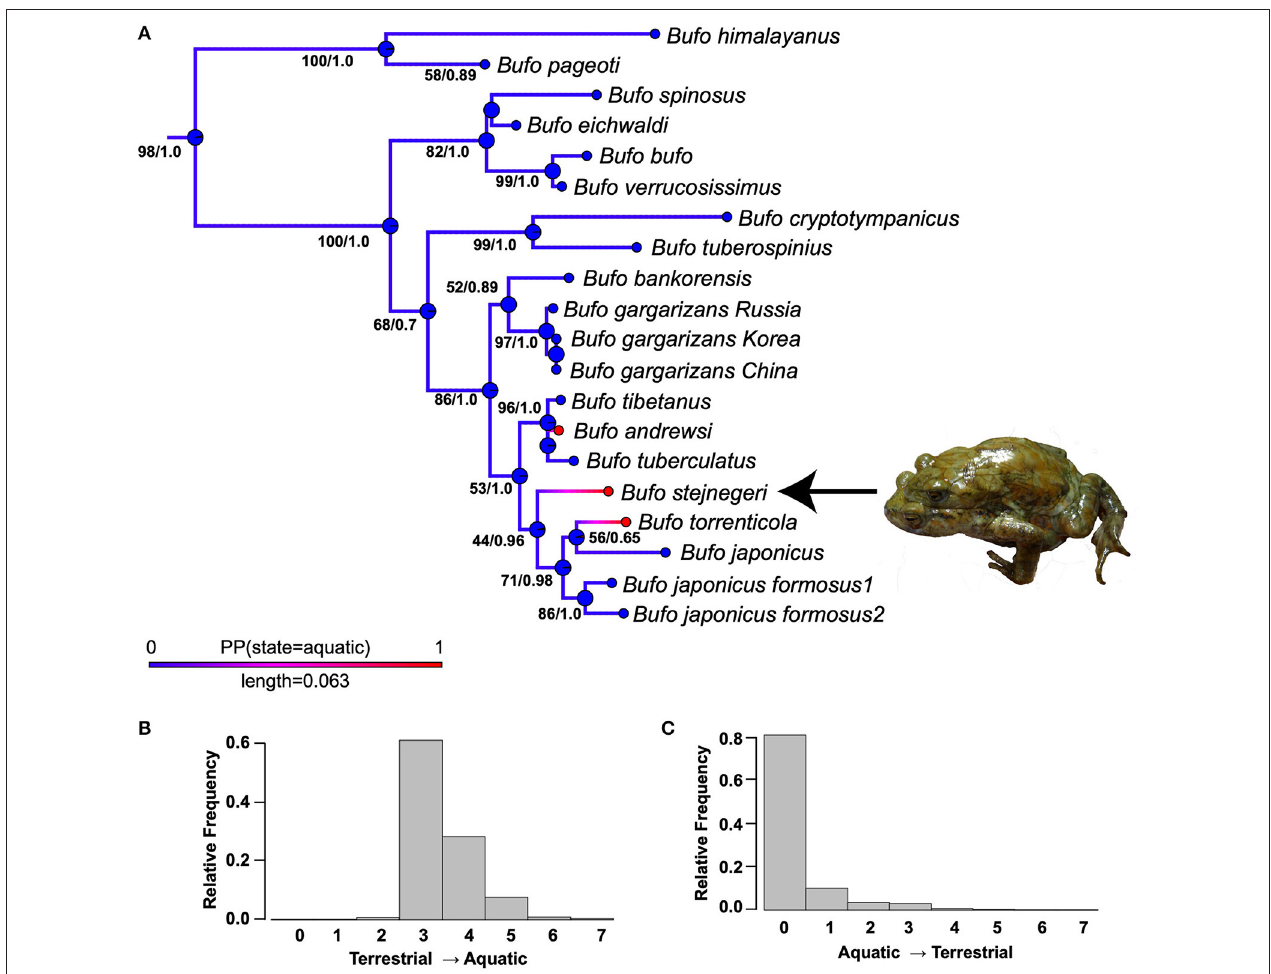
FIGURE 2 | (A) The phylogenetic placement of Bufo stejnegeri within the genus Bufo and ancestral state reconstruction of a semi-aquatic lifestyle. This phylogeny is from the partitioned maximum likelihood (ML) phylogenetic analysis performed on a concatenated dataset of three loci ( 12S-16S , CXCR-4 , POMC ). Numbers at nodes represent (ML bootstrap/Bayesian posterior probability). The Bayesian inference phylogeny only differed in branch lengths and support values of nodes. Colors of the branches represent the results from the ancestral state reconstruction analysis, while circles at the nodes represent inferred ancestor states nodes present the lifestyle state of each species. For branches, red represents a semi-aquatic lifestyle, blue represents a terrestrial lifestyle, while magenta-purple represent intermediate posterior probabilities. Plot probability distributions of the number of reconstructed changes across all simulated histories (B) terrestrial → aquatic and (C) aquatic →